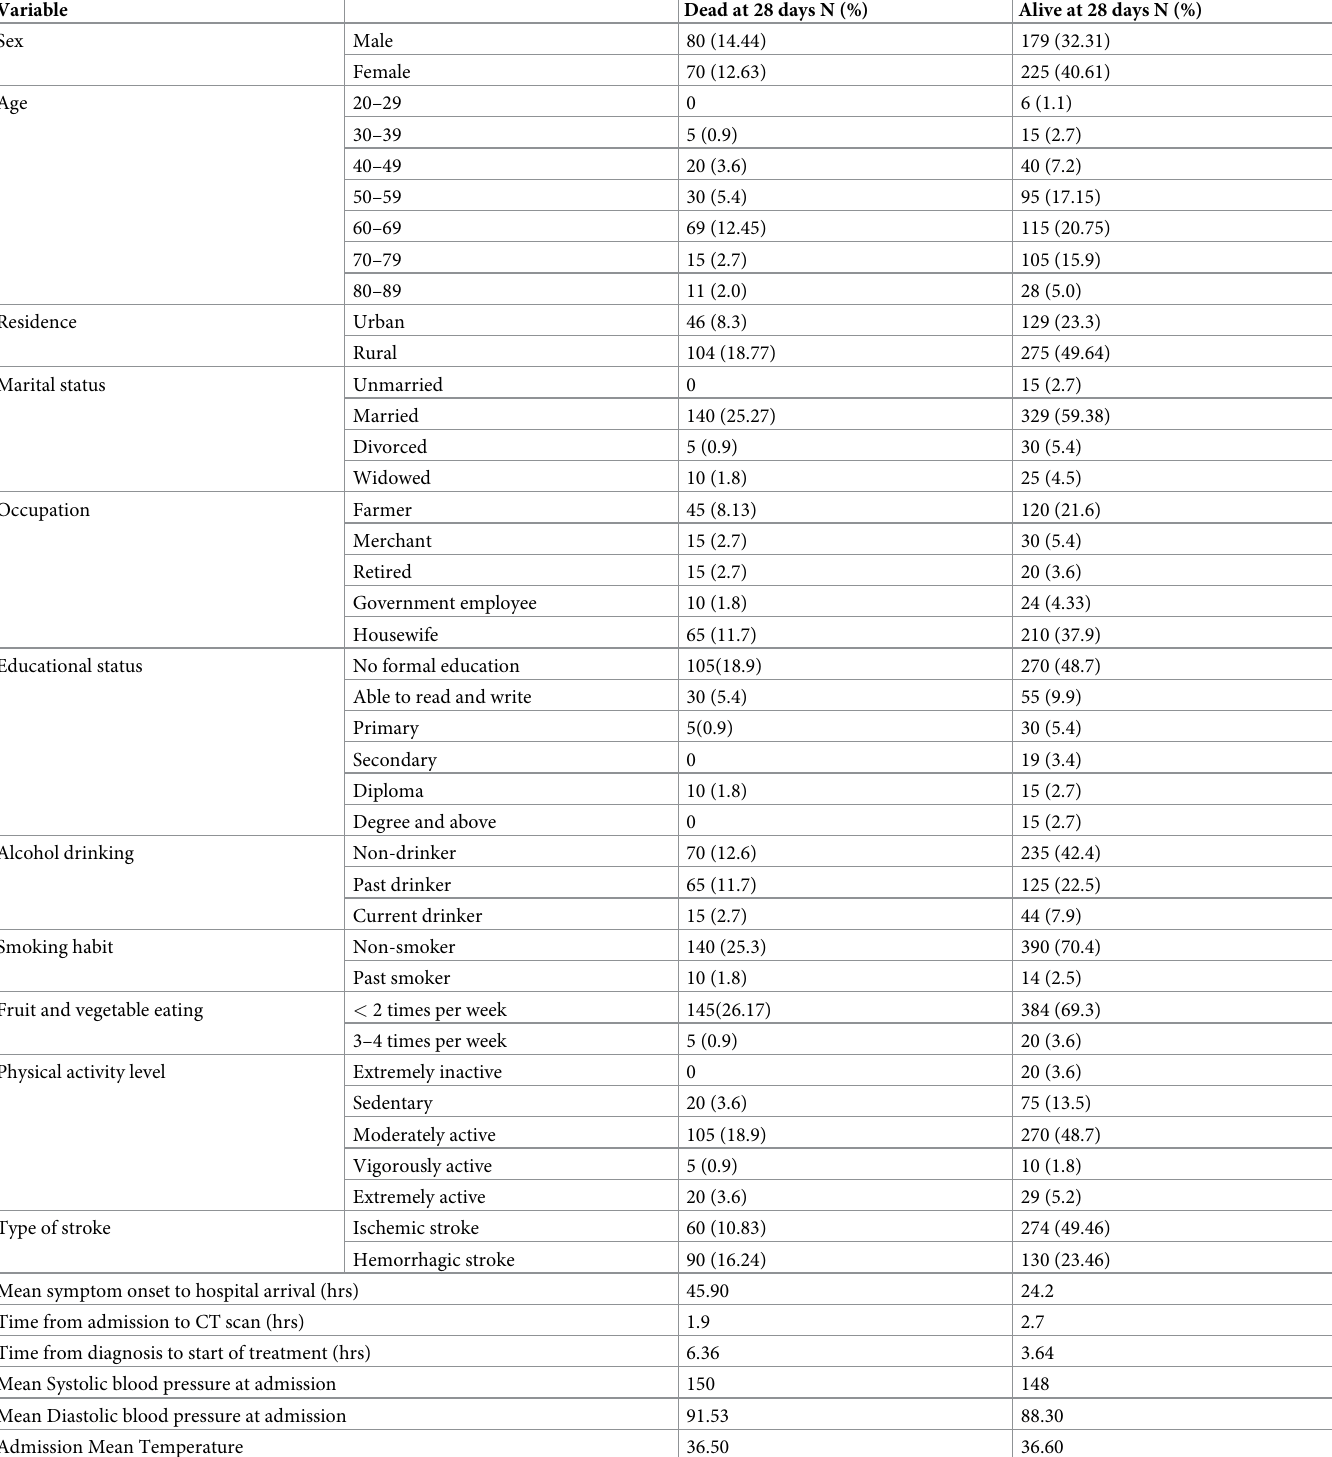
Table 2. Sociodemographic, behavioral, and baseline characteristics of stroke patients who were dead and alive after 28 days of follow up in public referral hospitals, Northwest